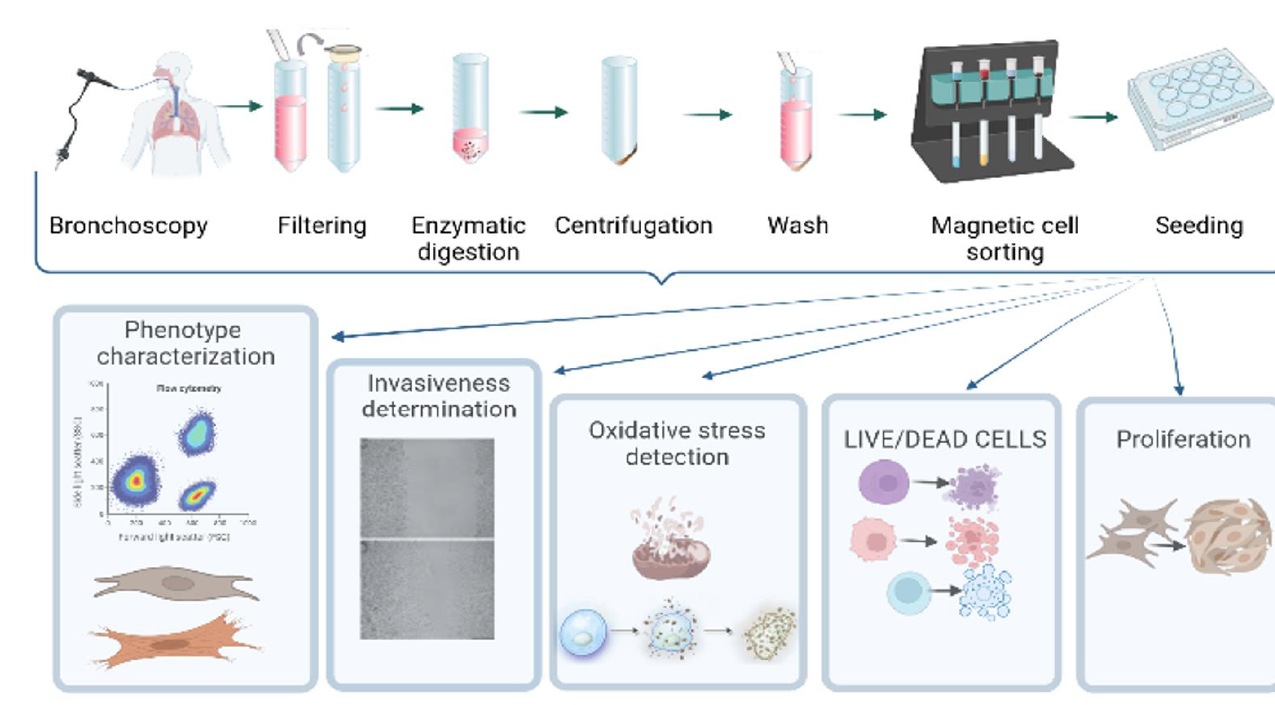
Figure 1. Flowchart of the study.